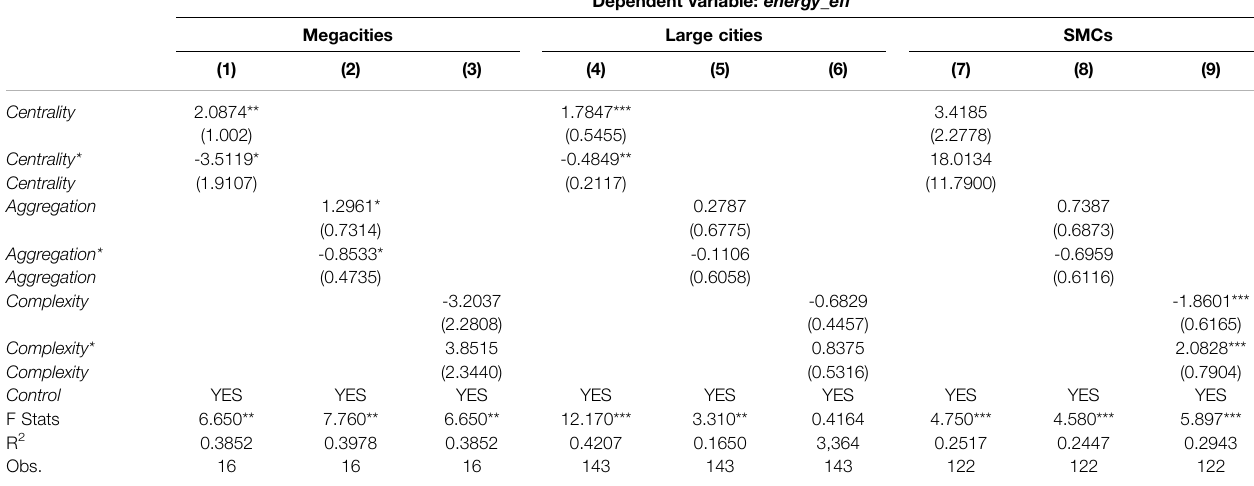
TABLE 4 | Urban heterogeneity analysis